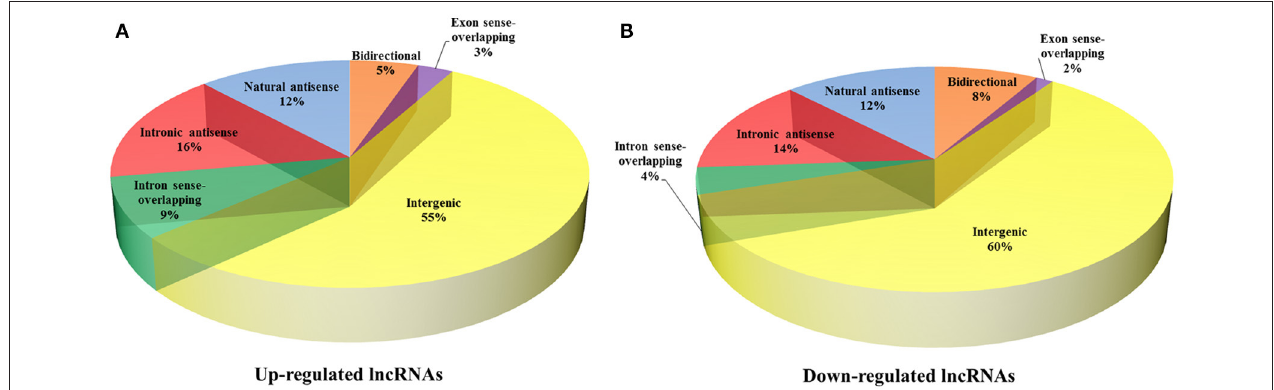
FIGURE 4 | Classification of differentially expressed lncRNAs and adjacent protein-coding genes. The 393 up-regulated lncRNAs (A) and 287 down-regulated lncRNAs (B) were further classified into six classes: bidirectional lncRNAs, exon sense-overlapping lncRNAs, intergenic lncRNAs, intron sense-overlapping lncRNAs, intronic antisense lncRNAs, and natural antisense lncRNAs.